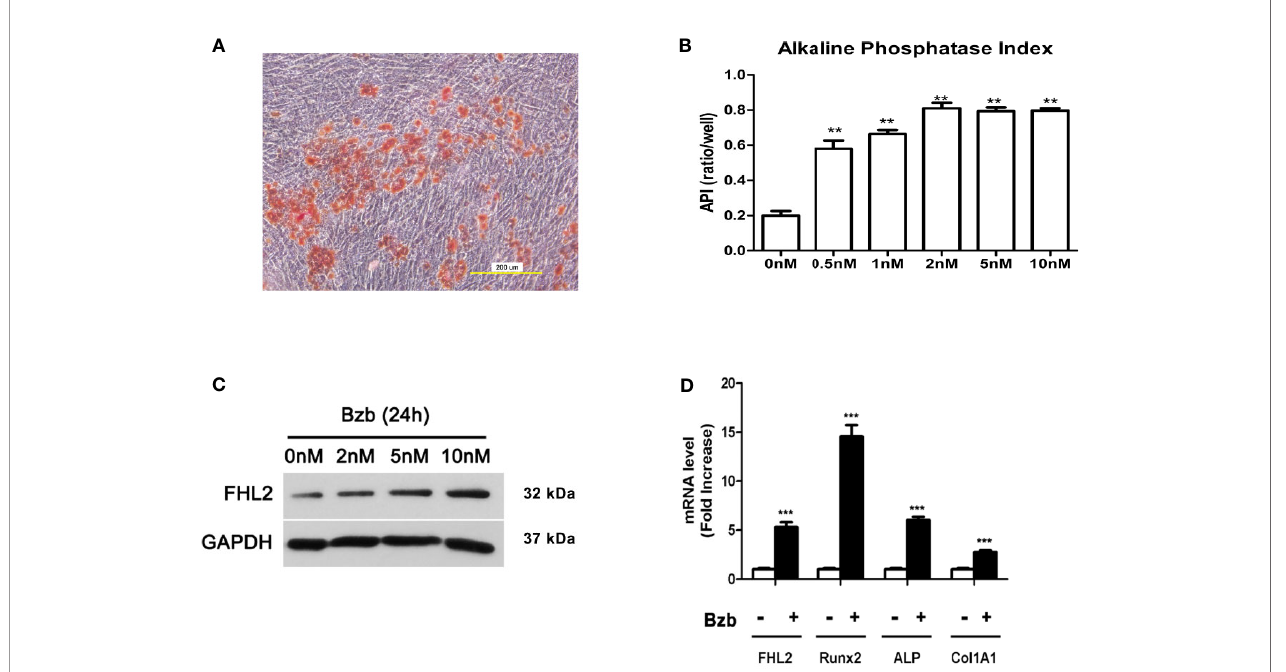
FIGURE 1 | FHL2 expression is upregulated during Bzb-induced osteoblast differentiation of MM-MSCs. (A) Alizarin red staining was performed to show the osteoblast activity of differentiated MM-MSCs. (B) MM-MSCs were treated with indicated concentrations of Bzb for 7 days, and alkaline phosphatase index (API) was measured. (C) The protein level of FHL2 was evaluated by Western blot analysis after 24 h at indicated concentrations of Bzb. (D) FHL2 and osteoblast markers Runx2, ALP, and Col 1A1 mRNA expression was determined by quantitative RT-PCR at day 7. Results are expressed as mean ± SD (n = 3). **p < 0.01 vs . controls, ***p < 0.001 vs .